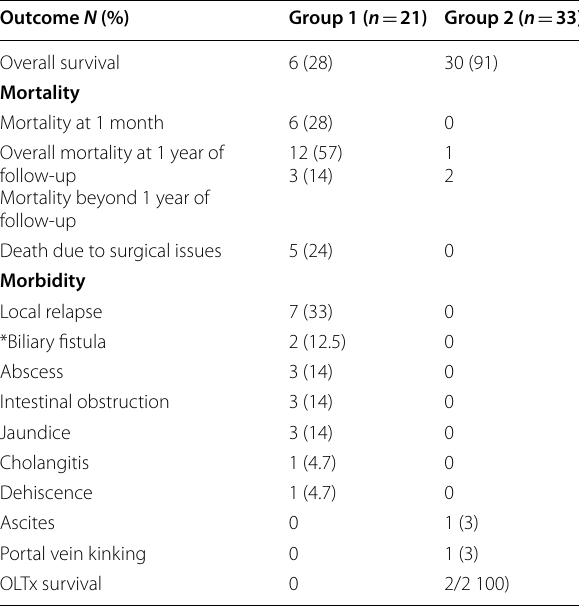
Table 4 Summary of clinical outcomes of all patients-benign and malignant